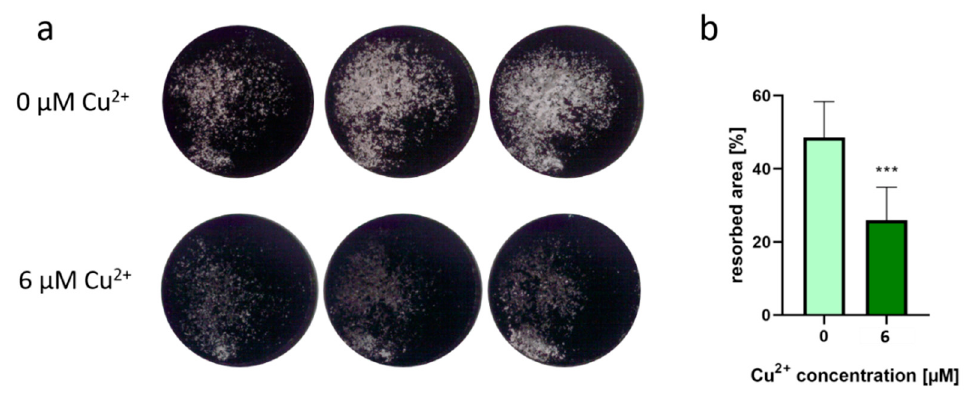
Figure 6. ( a ): Representative images of osteoblast-derived ECM after osteoclastic resorption in the presence of 6 µM Cu 2+ compared to a copper-free control. SaOS-2 osteoblasts were cultivated for 4 weeks until a closed layer of mineralized extracellular matrix was formed in the dishes. After re- moval of the osteoblasts, PBMC (two donors, each n = 4 per group) were seeded and cultivated for 14 days under stimulation with M-CSF and RANKL with and without addition of Cu 2+ . After fix- ing with 4 % formaldehyde, von Kossa staining was performed to stain the remaining mineralized matrix after osteoclastic resorption. Images were recorded with a Leica stereomicroscope and rep- resent the whole area of a 48- well dish (12 mm diameter). ( b ): Resorbed area of all samples was calculated applying the open source software Fiji using the threshold function. Eight samples were imaged for each condition and shown as mean +/ − standard deviation. Significant differences were calculated by two-tailed unpaired t-test with p < 0.001.